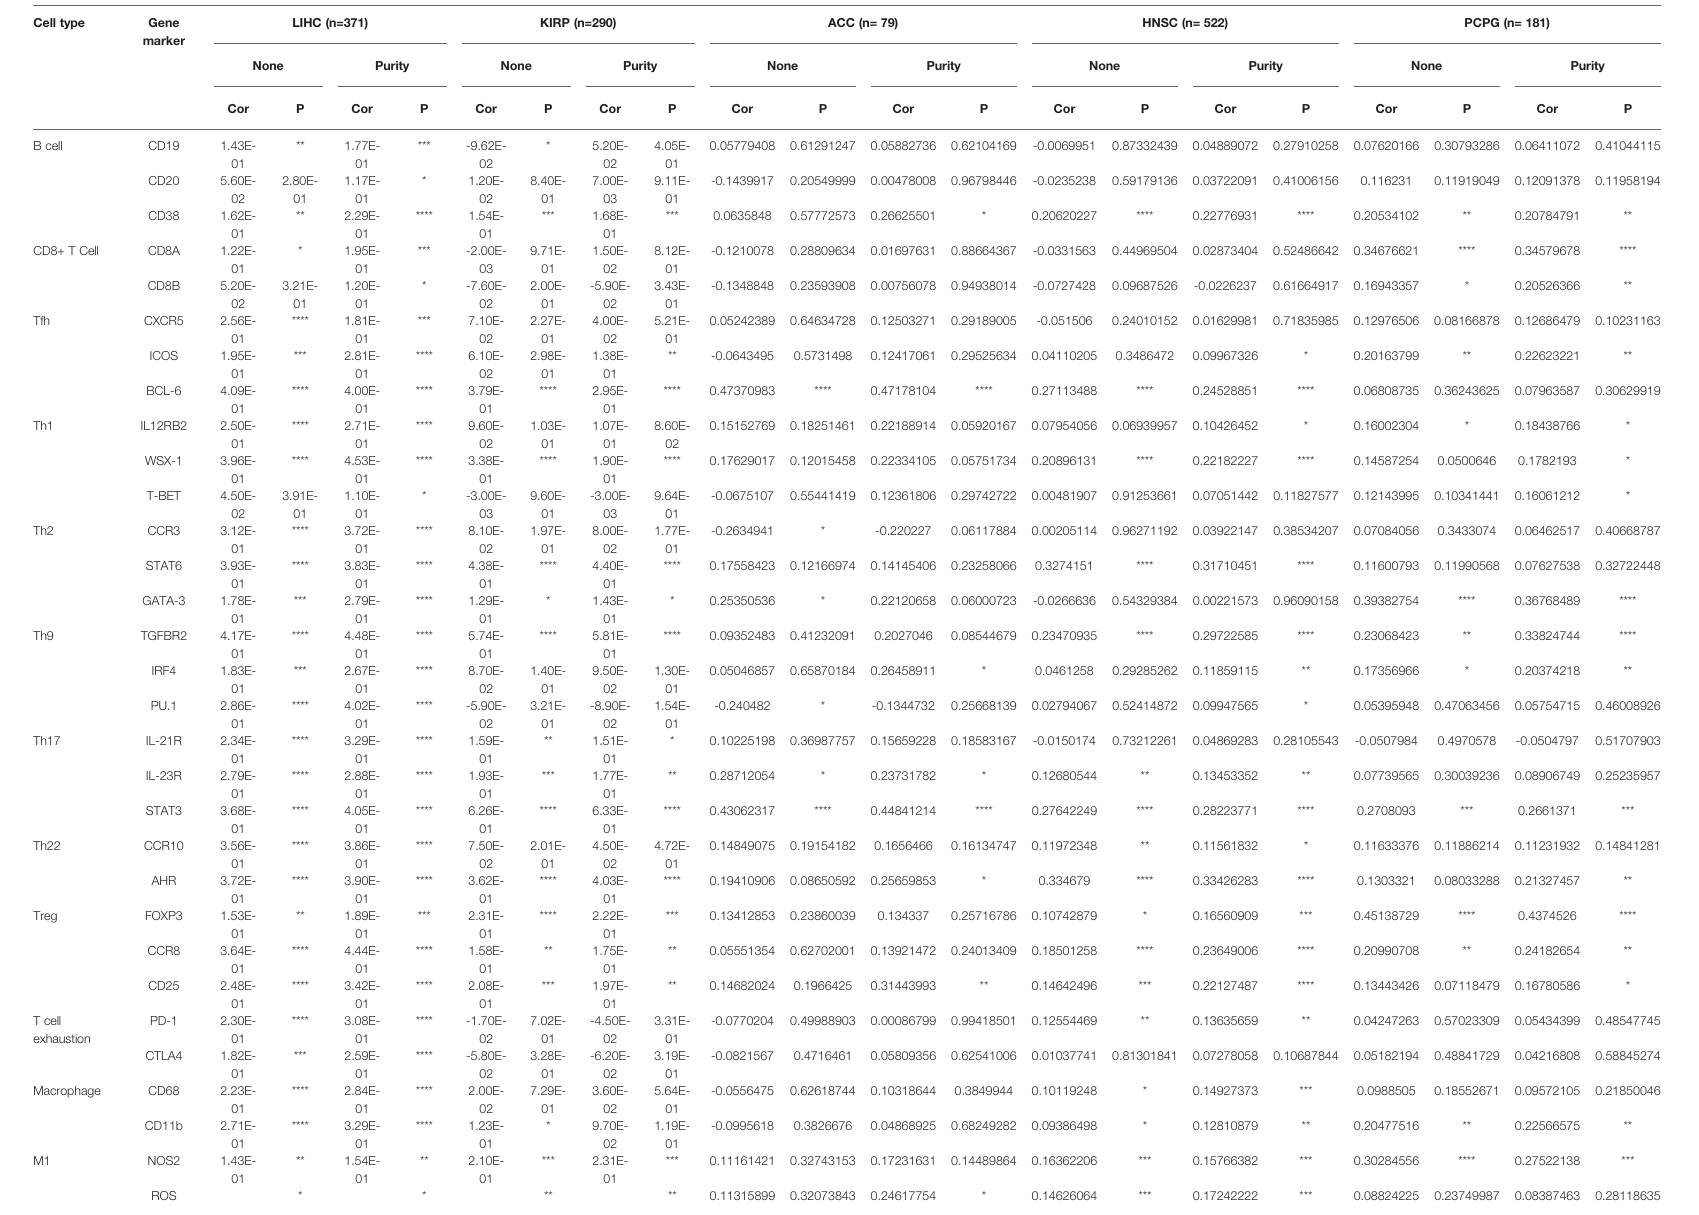
TABLE 1 | Correlation analysis between NAT10 and related genes and markers of immune cells in TIMER2.